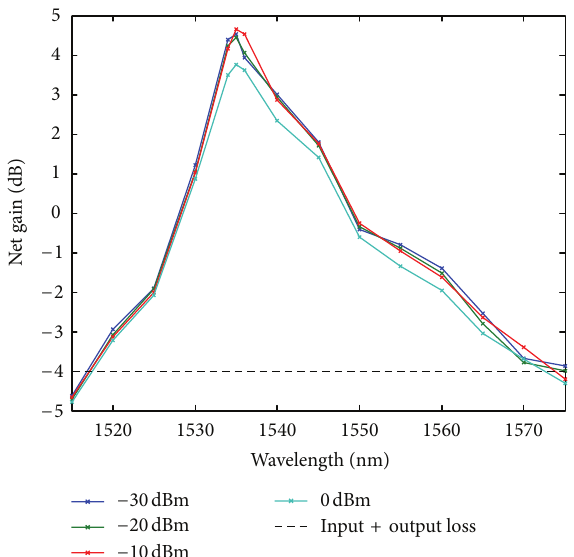
Figure 5: Signal net gain spectrum obtained for four different signal input powers − 30 dBm, − 20dBm, − 10dBm, and 0dBm at wavelengths ranging from 1515 to 1575 nm. Injected pump power is = 237 mW. 𝑃 𝑝